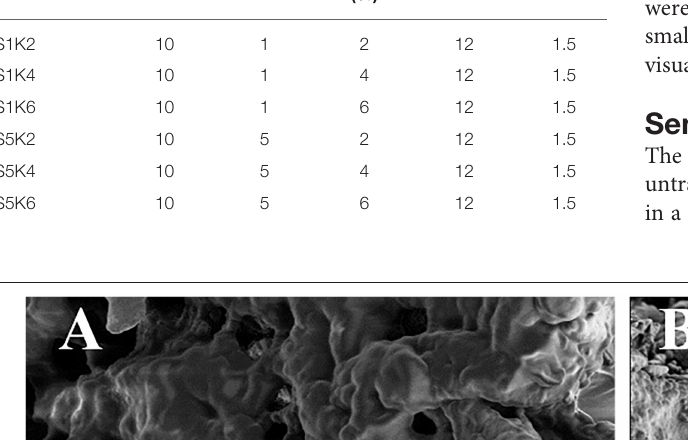
Frontiers in Nutrition |